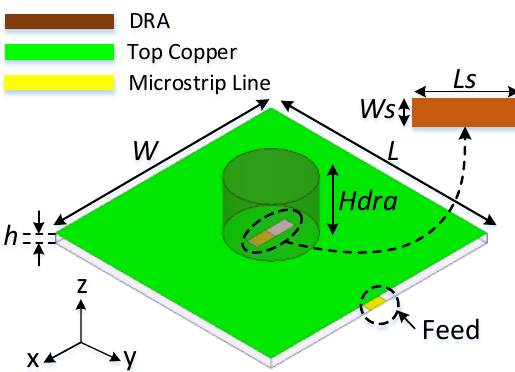
Figure 1. Proposed cylindrical dielectric resonator antenna to be used as a sensor ( Ls = 7 mm, Ws = 2 mm, Hdra = 9 mm, h = 1.6